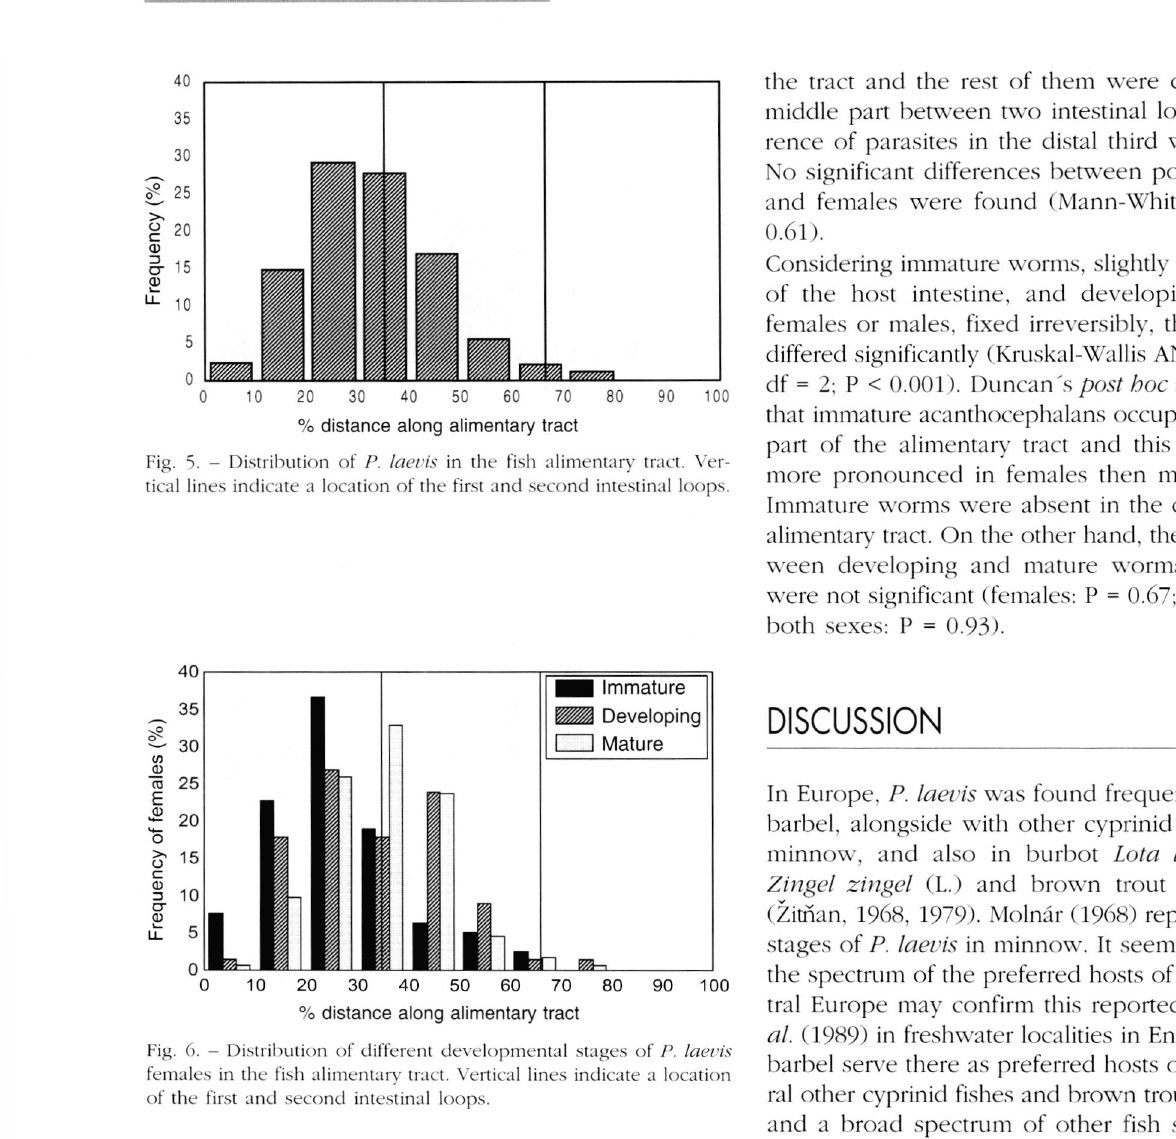
Fig. 6. — Distribution of different developmental stages of P. laevis females in the fish alimentary tract. Vertical lines indicate a location of the first and second intestinal loops.